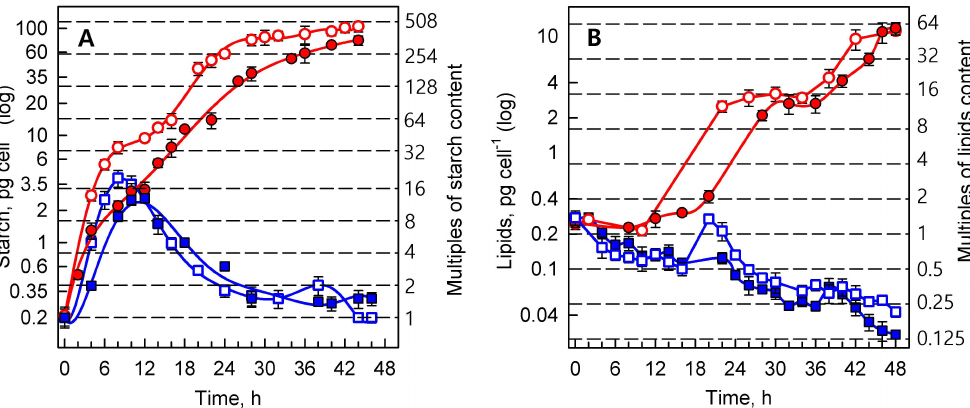
Figure 3. The course of changes in energy reserves in synchronized cultures of Parachlorella kessleri at temperatures of 30 ◦ C and 40 ◦ C (blue and red symbols and lines, respectively), and at incident light intensities of 500 and 110 µ mol photons m − 2 s − 1 (empty and full symbols, respectively). ( A ) Starch (pg cell − 1 ), and ( B ) lipids (pg cell − 1 ). Horizontal dashed lines indicate the number of doublings of the initial values at the beginning of the cell cycle (0 h). Multiples of these values are given on the right ordinate. Data are presented as means ± SE. The differences between 30 ◦ C and 40 ◦ C are statistically significant at p < 0.001 (two-way ANOVA) in both A and B. The differences between different light intensities in A are statistically significant at p < 0.05 (two-way